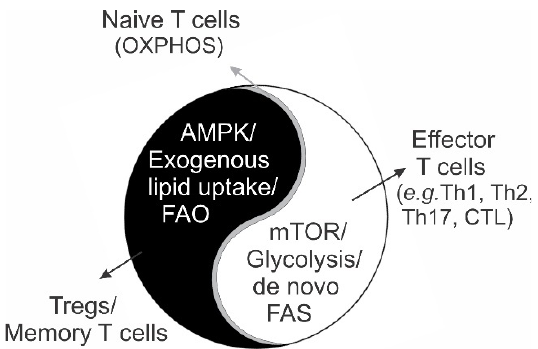
Figure 2. The Yin-Yang balance of T cell metabolism. Naïve T cells remain quiescent by fully metabolizing the basal amount of glucose into ATP, CO 2 and H 2 O through mitochondrial oxidative phosphorylation (OXPHOS). Once exposed to antigen stimulation (e.g., TCR/CD28 signals), naïve T cells rapidly upregulate the uptake of environmental nutrients (e.g., glucose) via activation of the PI3K/AKT/mTOR pathway and switch to aerobic glycolysis to meet the bioenergetic and biosynthesis needs for the clonal expansion and differentiation of antigen-specific effector T cells (Yang side). To prevent T cell overactivation, Tregs are activated by the AMPK/FAO pathway to suppress effector T cell proliferation during the process (Yin side). Upon antigen clearance, activated T cells can develop into memory T cells, which adopt similar FAO metabolism to maintain their long-term survival. The Yin-Yang balance model of T cell metabolism coined here not only describes the functional and metabolic complements of individual T cell subsets, but also help to explain the overall homeostasis and harmony of T cell responses in vivo as a whole.